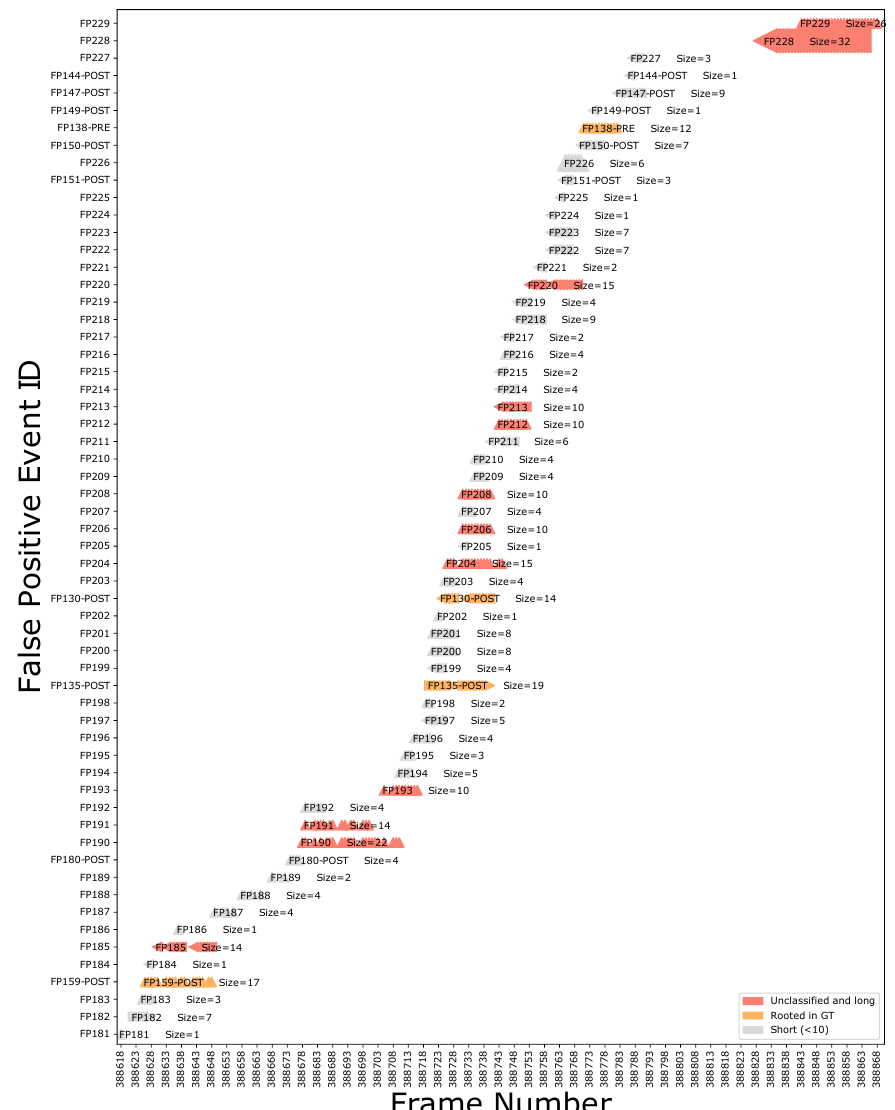
Figure 5. Visualization of results for false positive event analysis. Orange color marks false positives rooted in GT. ID for those events contains ID of the original GT event and information whether the false positive is rooted in the beginning (PRE) or at the end of event (POST). Gray events are not stable and long enough to be considered significant. Red events are unclassified and long, thus have the priority in further